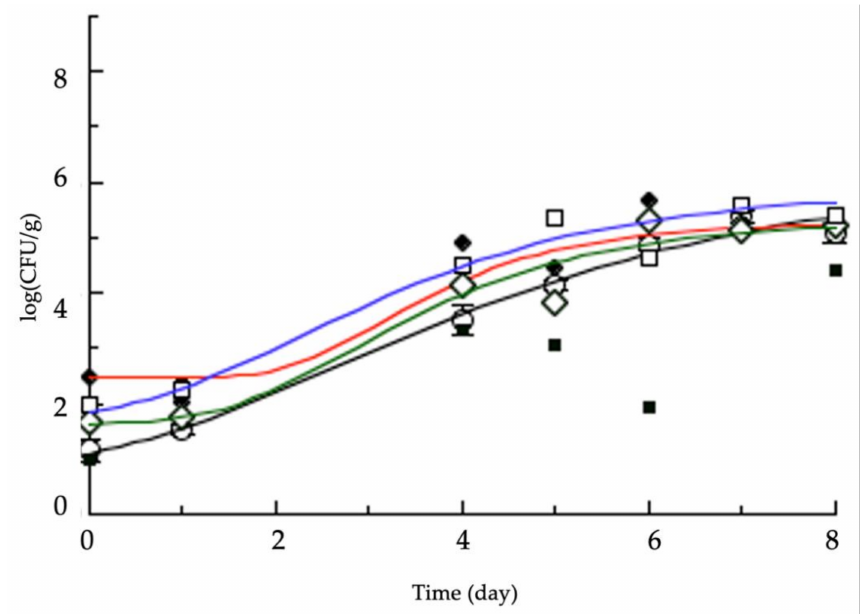
Figure 2. Best fit of the modified Gompertz equation (Equation (1)) to the experimental data on the growth kinetics of total coliforms. Experimental data are presented as means ± standard